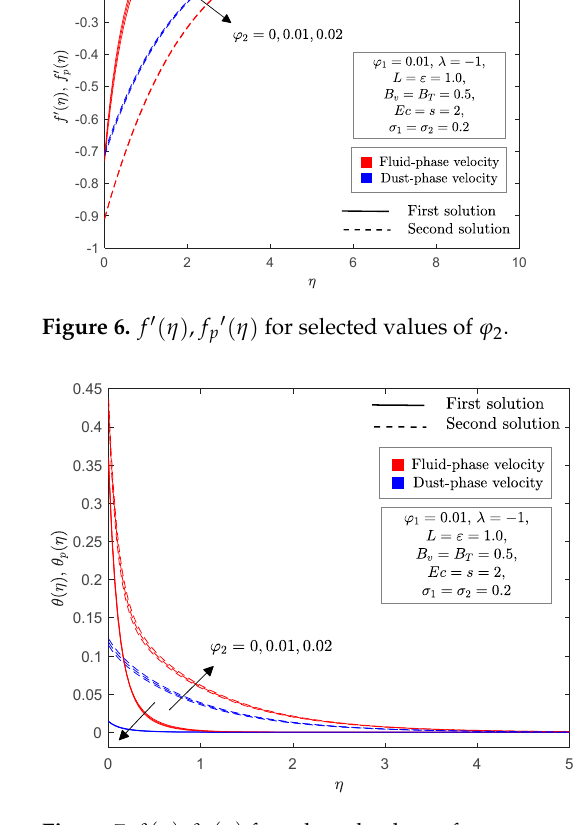
Figure 5. with λ for various Figure 5. thermal slip parameter σ 2 , as this parameter caused no changes in the velocity profiles.